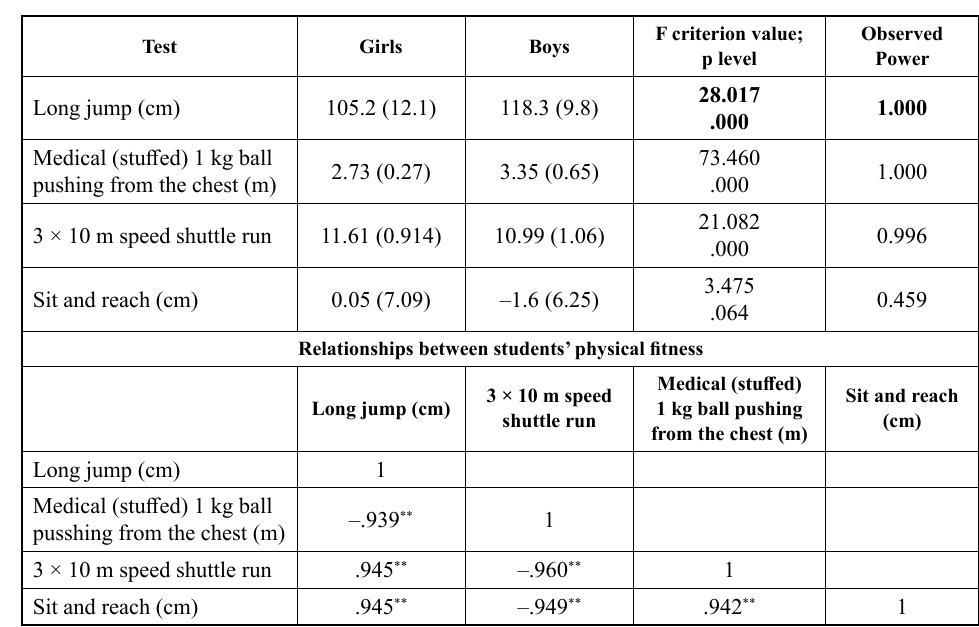
Table 2. Comparison of 7- year-old boys’ and girls’ indicators of physical fitness